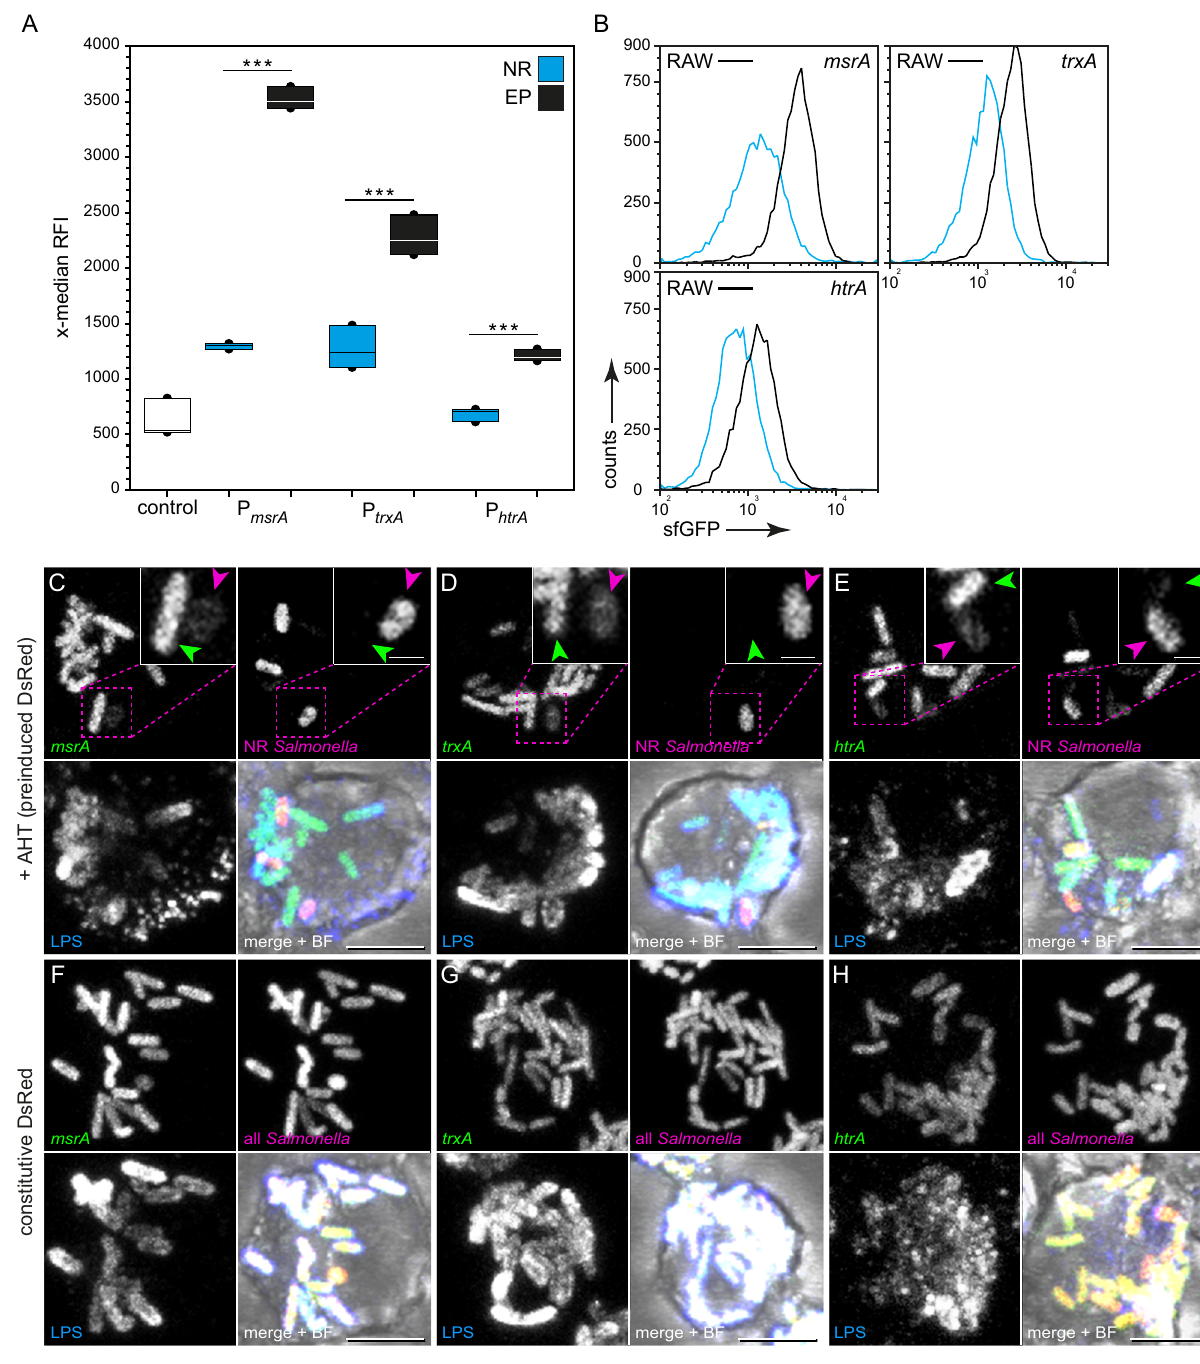
Fig. 2 Lower levels of stress response of non-replicating STM WT compared to replicating intracellular STM. STM WT harboring AHT-inducible (NR, blue bars) or constitutive (EP, black bars) dual- fl uorescence reporter for msrA, trxA and htrA were grown o/n in LB medium containing 50 ng × ml − 1 AHT. Before infection of RAW264.7 macrophages, AHT was removed. At 8 h p.i., infected cells were lysed, or fi xed for FC analyses ( A , B ), or microscopy ( C – H ), respectively. For FC, released STM were recovered, fi xed, and analyzed. As non-induced control, dual FP reporter plasmids were used with a frameshift mutation in sfgfp (described before in the ref. 40 ). A The x-median represents the stress-induced sfGFP signal of the DsRed-positive intracellular bacterial population 8 h p.i. Means and standard deviations of one representative experiment are shown. B Representative histograms corresponding to A are shown. Statistical analysis was accomplished by SigmaPlot by One Way ANOVA and signi fi cance levels are indicated as follows: * p < 0.05; ** p < 0.01; *** p < 0.001; n.s. not signi fi cant. C – H The entire population of intracellular STM was detected by immuno-staining of O antigen (blue). F – H Constitutively dsred - expressing STM represent the entire intracellular bacterial population. C – E NR and R STM were positive or negative for DsRed fl uorescence (magenta), respectively. sfGFP signals (green) indicate induction of msrA, trxA, or htrA . Representative NR STM and R STM are indicated by magenta and green arrowheads, respectively. Scale bars, 5 (overview), 1 µ m